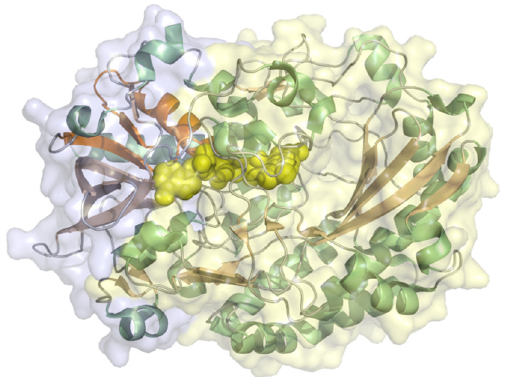
Figure 4. Crystal structure of Aspergillus niger glucose oxidase (PDB: 3QVR) with the FAD cofactor (yellow spheres) buried inside the protein. The FAD-binding and substrate-binding subunits are colored light blue and light yellow, respectively. The GMC-oxidoreductase family characteristic dinucleotide binding βαβ -motif (Rossmann-fold) is highlighted in orange.